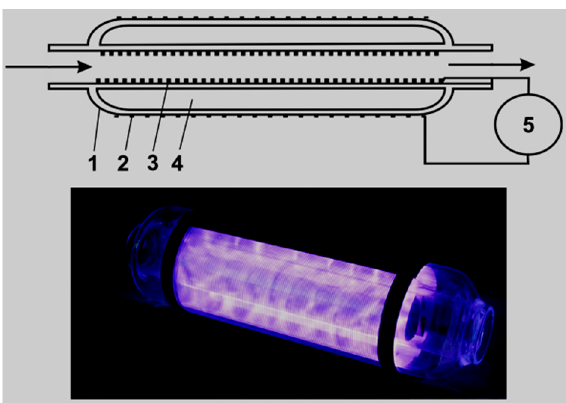
Figure 15. Coaxial excilamp design ( top ) and external view during operation ( bottom ): 1—excilamp bulb; 2—external perforated electrode; 3—internal perforated electrode; 4—discharge gap; 5—high- frequency voltage generator.